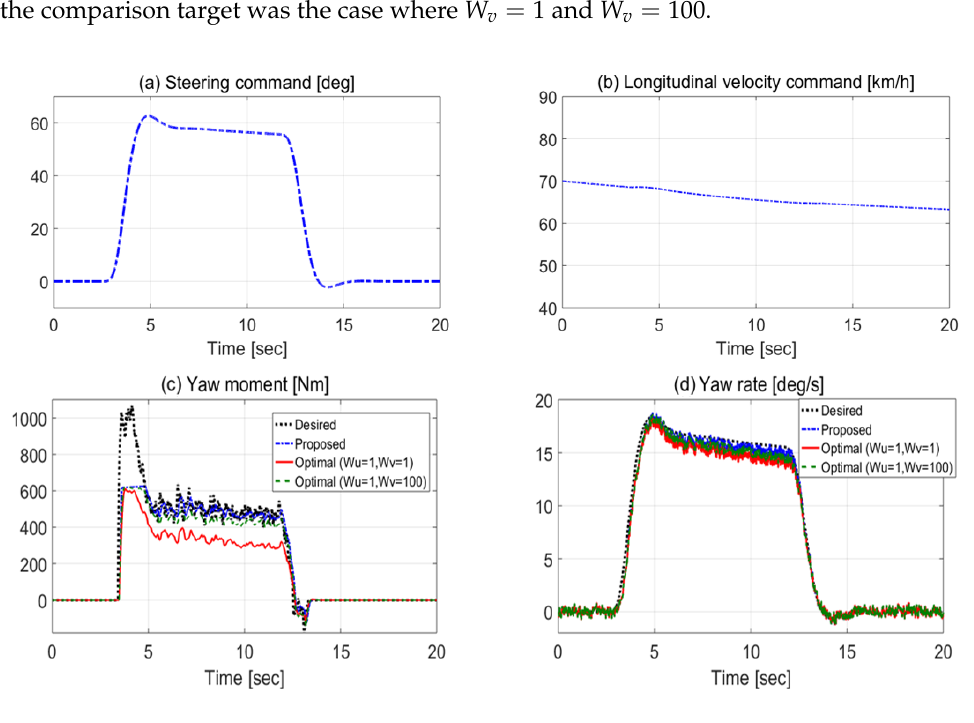
Table 3. Comparison of allocation methods (simulation results).